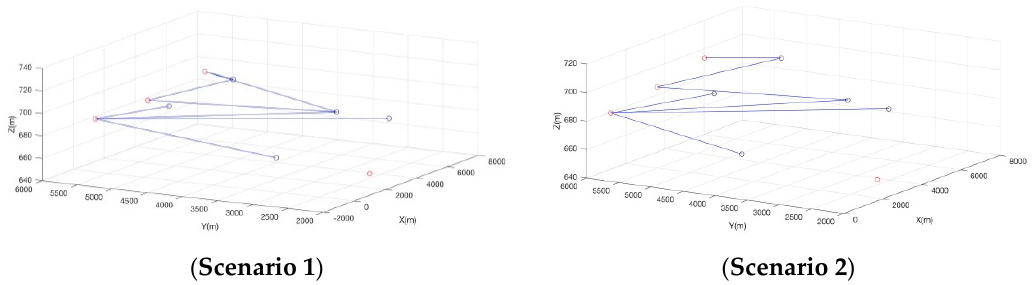
Figure 6. Distribution of UAVs during a threat in two scenarios.